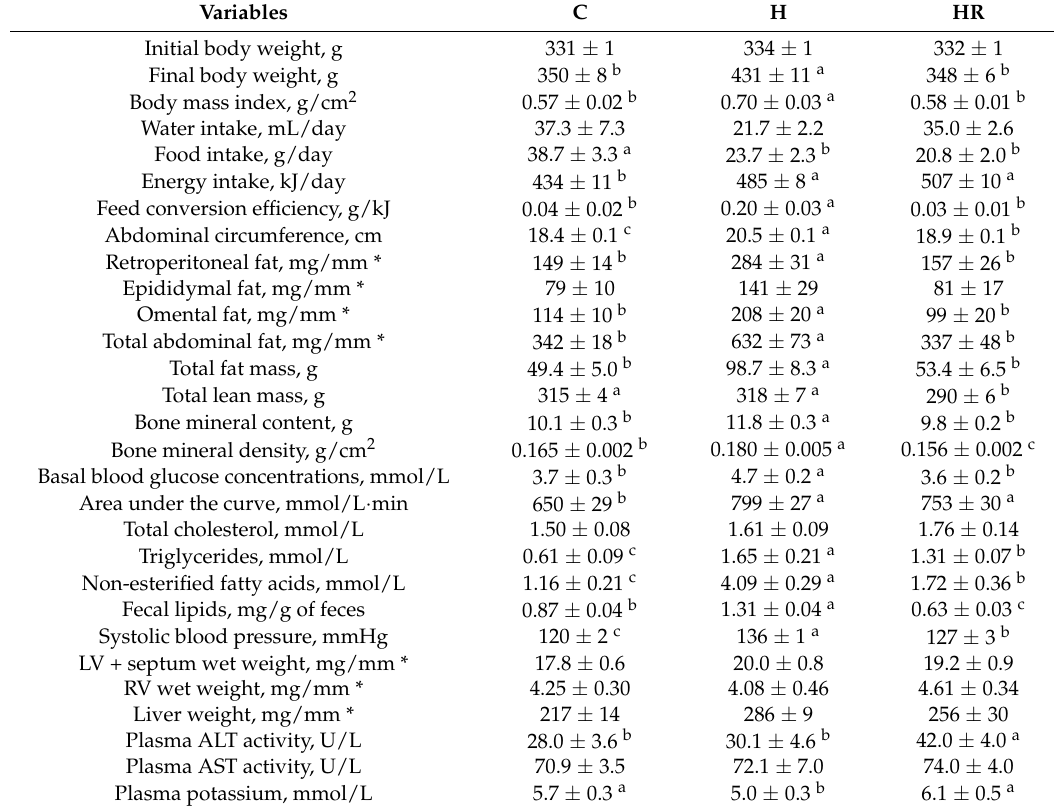
Table 1. Effects of Kappaphycus on metabolic, body composition, and physiological